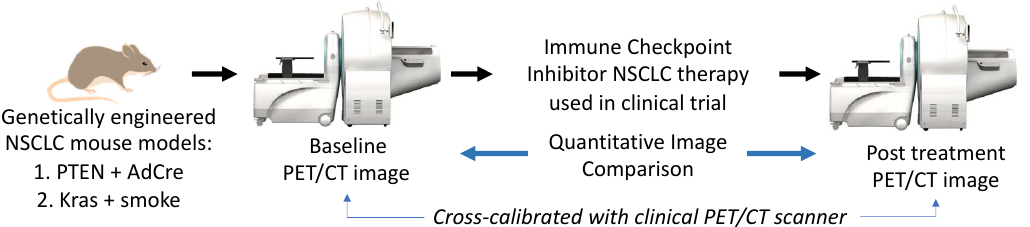
Figure 10. High-level schematic of co-clinical trial using PET imaging to develop image-based response criteria for preclinical studies of immune checkpoint inhibitor therapies in non-small cell lung